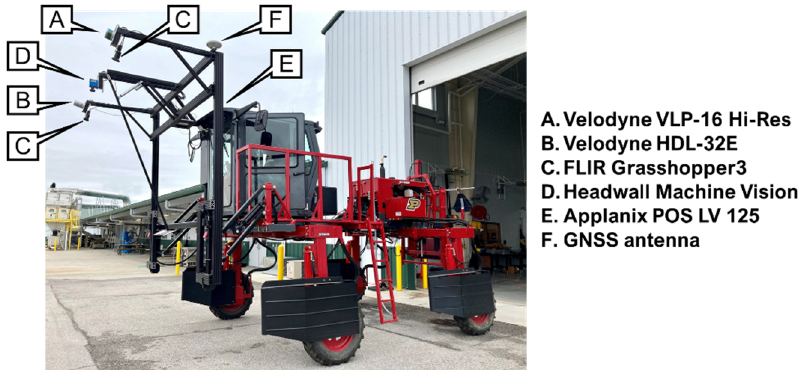
Figure 5. The ground mobile mapping system (PhenoRover) and onboard sensors used in this